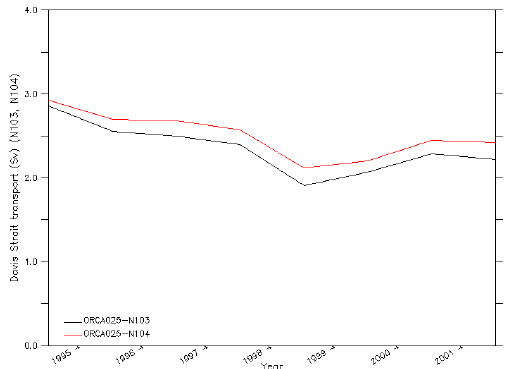
Fig. 15. Annual-mean southward volume transport in Davis Strait (Sv, positive southward) over 1995–2001, in control experiment (red curve) and sensitivity experiment (black